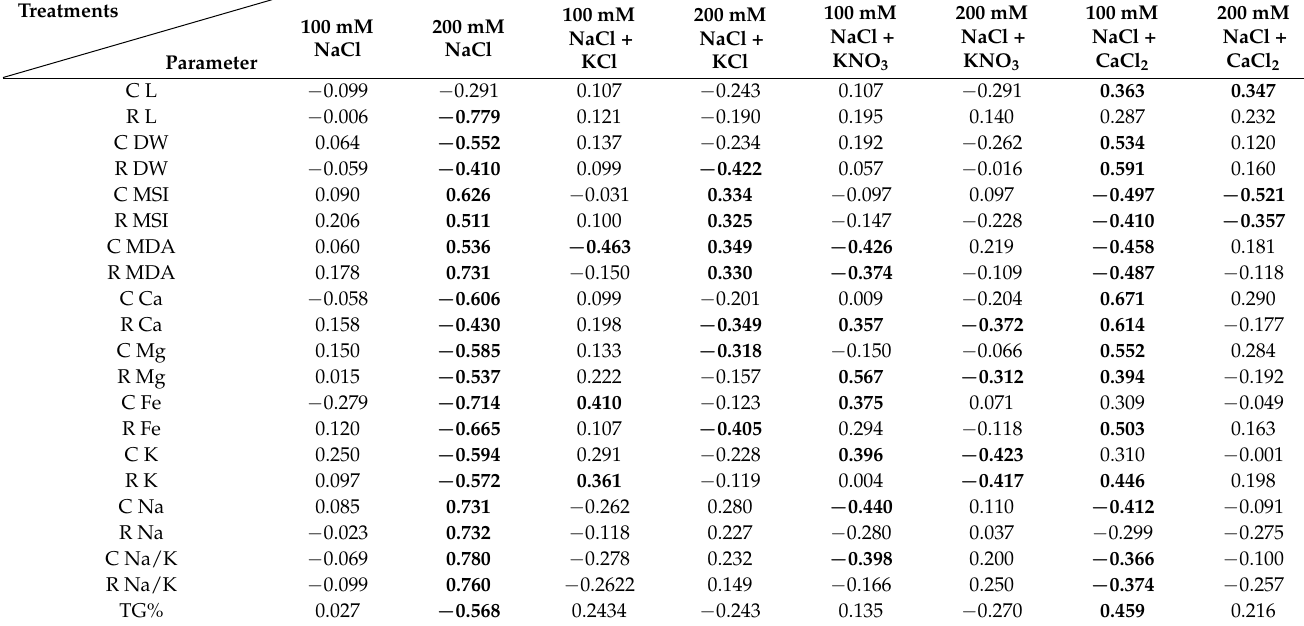
Table 4. Hordeum maritimum Pearson’s correlation matrix: C L: coleoptile length; R L: radicle length; C DW: coleoptile dry weight; R DW: radicle dry weight; C MSI: coleoptile membrane stability index; R MSI: radicle membrane stability index; C MDA: coleoptile malondialdehyde content; R MDA: radicle malondialdehyde content; C Ca: coleoptile calcium content; R Ca: radicle calcium content; C Mg: coleoptile magnesium content; R Mg: radicle magnesium content; C